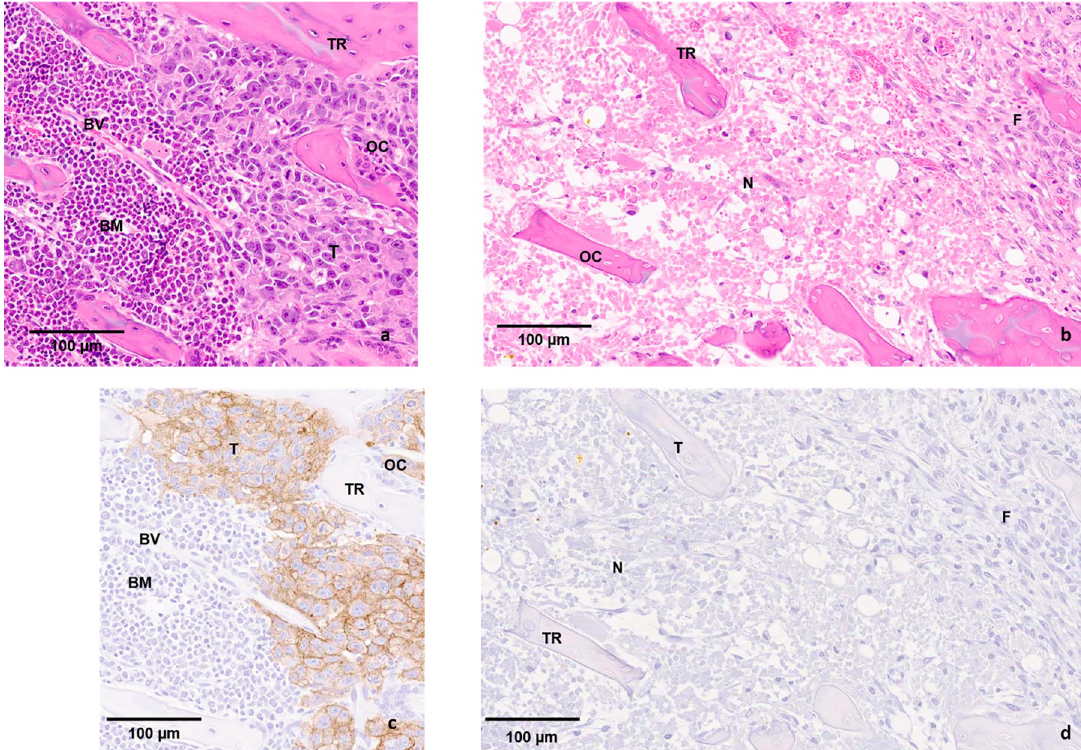
Fig 4. Histopathology of metastatic bone tissue. Histology section of the femur with osteolytic metastases: a) Tumor cells (T; HeLa) in the mid-sagittal section of a distal femur (BM: bone marrow; TR: trabeculae; OC: osteoclast; BV: blood vessel) b) Mid-sagittal section of a distal femur 1-week post RFA. Tumor cells are necrotic (N); osteocytes (OC) are dead within the trabeculae of the treated area surrounded by RFA-induced fibrous tissue (F) formation. c) Tumor cells (T) are staining positive for the hEGFr antibody in the mid- sagittal section of a distal femur (BM: bone marrow; TR: trabeculae; OC: osteoclast; BV: blood vessel) d) Mid-sagittal section of a distal femur 1 week post RFA. Tumor cells are necrotic (N), no longer stain positively and fibrous tissue (F) is formed within the treated area. https://doi.org/10.1371/journal.pone.0256076.g004 Table 1). The susceptibility ratios were also significantly increased in RFA-treated age-matched healthy cohorts in comparison to the age-matched untreated healthy bone tissue (Day 84: 2.472 vs. 2.420, p = 0.003; Day 21: 2.472 vs. 2.406, p = 0.003, Table 1). Elevated susceptibility ratio values are associated with enhanced disorganization, disrupted in-plane alignment and increased degree of disorder in collagen type I fibrils. Statistically significant differences were not observed in RFA-treated metastatic cohorts compared to untreated metastatically involved bone tissue.